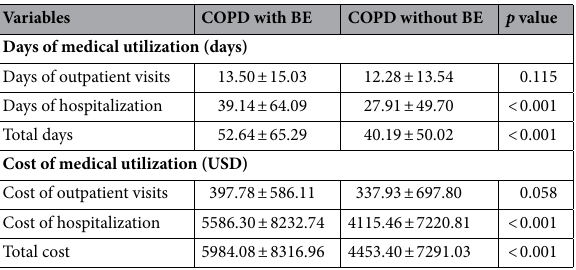
Table 4. Medical cost of medical utilization. Data are expressed as mean ± standard deviation. BE bronchiectasis.